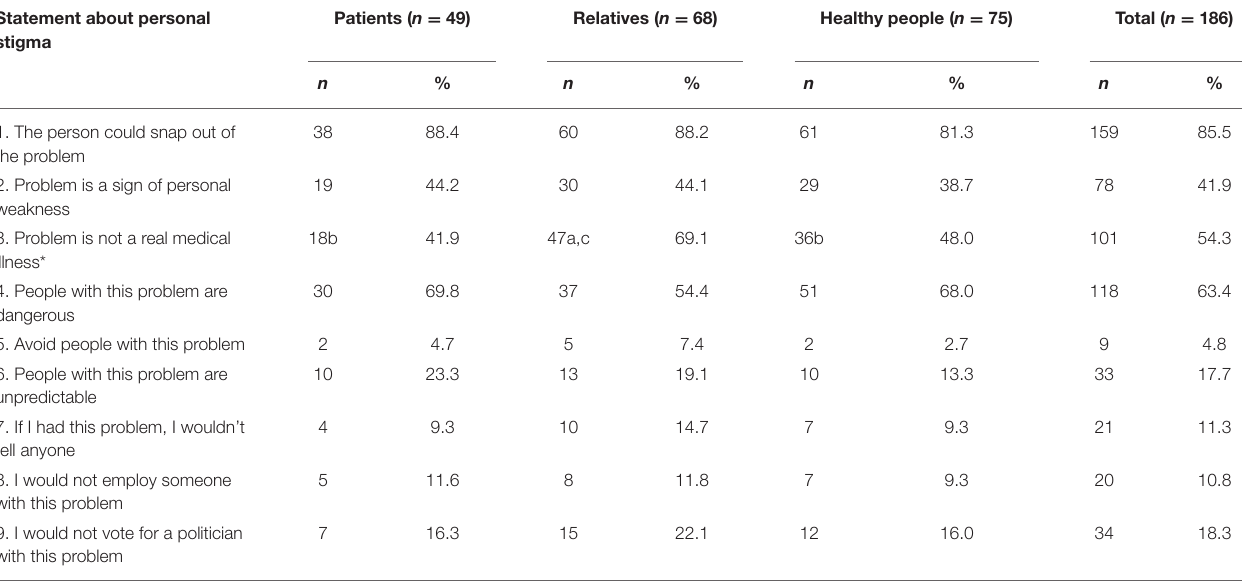
TABLE 2 | Compared on each statement about participants’ own attitudes toward the person in